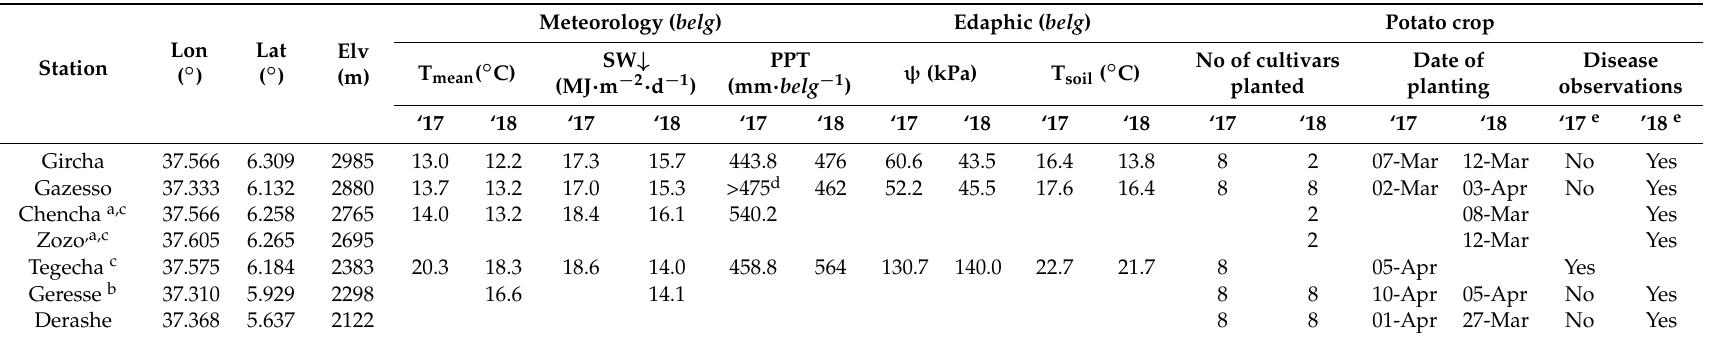
Table 1. Descriptions of the crop experimental sites with the belg (Feb-May) average seasonal weather (mean T mean , mean SW ↓ , and belg total PPT); edaphic (mean soil moisture ( ψ ) and mean soil temperature (T soil ); and some of the potato crop experimental descriptions in belg -2017 (‘17) and belg -2018 (‘18). Note that the GEMS location deviates a few meters from the farm sites. The soil sensors were placed at four depths: 5, 10, 20, and 40 cm, in which averages of the four depths